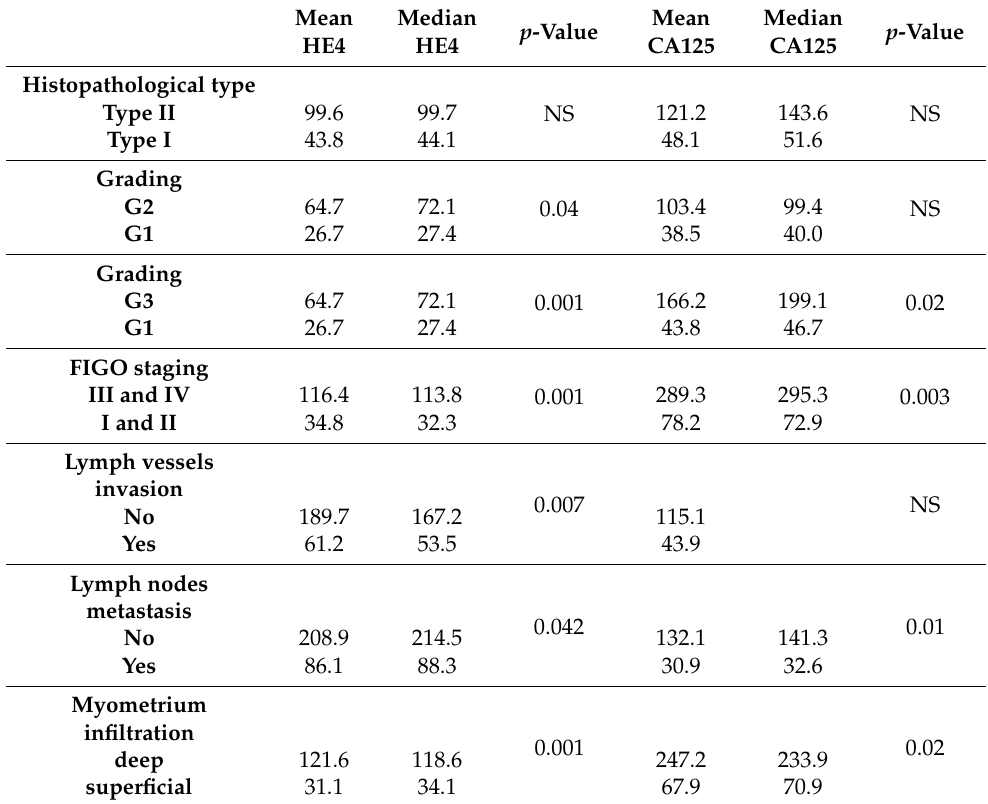
Table 2. Comparative analysis of both markers, HE4 and CA125, as prognostic